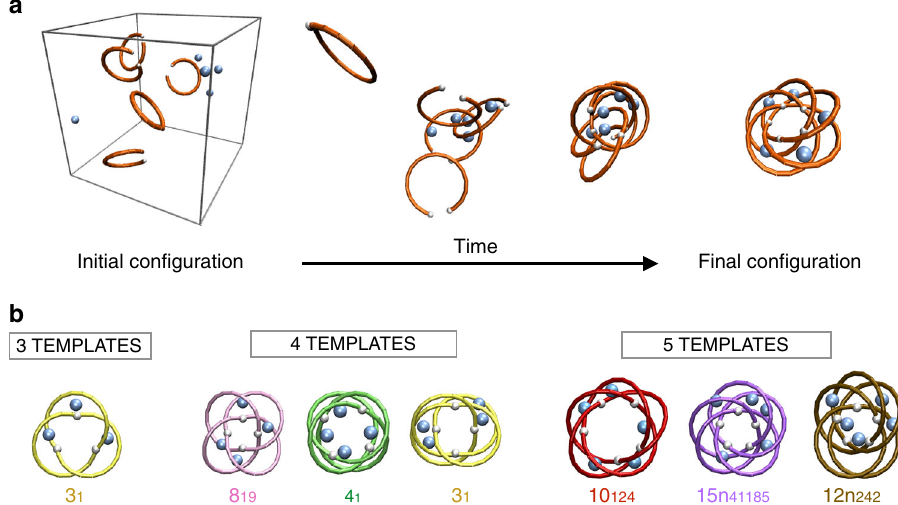
Fig. 3 Kinetically accessible topologies from self-assembly simulations. a Series of snapshots from a molecular dynamics simulation where fi ve helical templates and an identical number of coordinating particles self-assemble spontaneously into a cyclic-symmetric 15 n 41185 knot. This topology and the 10 124 one emerge as two privileged knot types that have not yet been obtained experimentally. b Repertoire of cyclic-symmetric quasi-planar knotted constructs that recurrently form in self-assembly simulations. The 12 n 242 -knotted construct is nearly cyclic-symmetric and is included for its high statistical incidence. For visual clarity the templates are represented with their centerline, omitting the constitutive